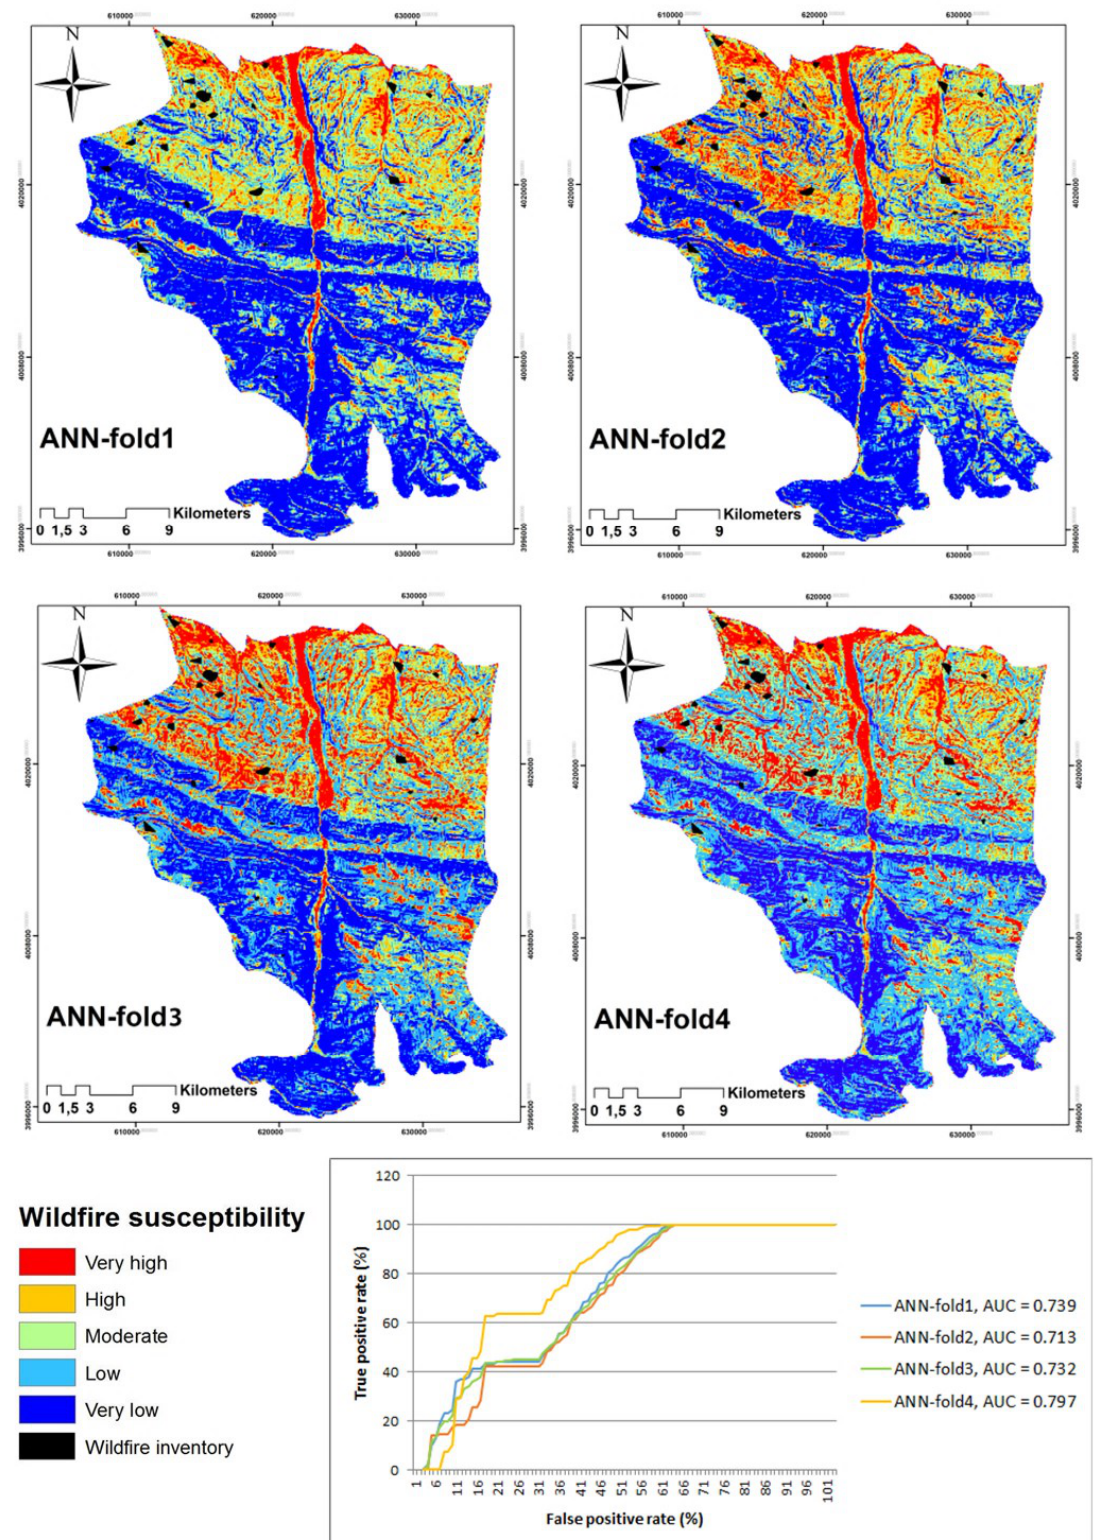
Figure 6. Spatial prediction of wildfire susceptibility maps using an ANN and the area under the curve (AUC) results based on four-fold